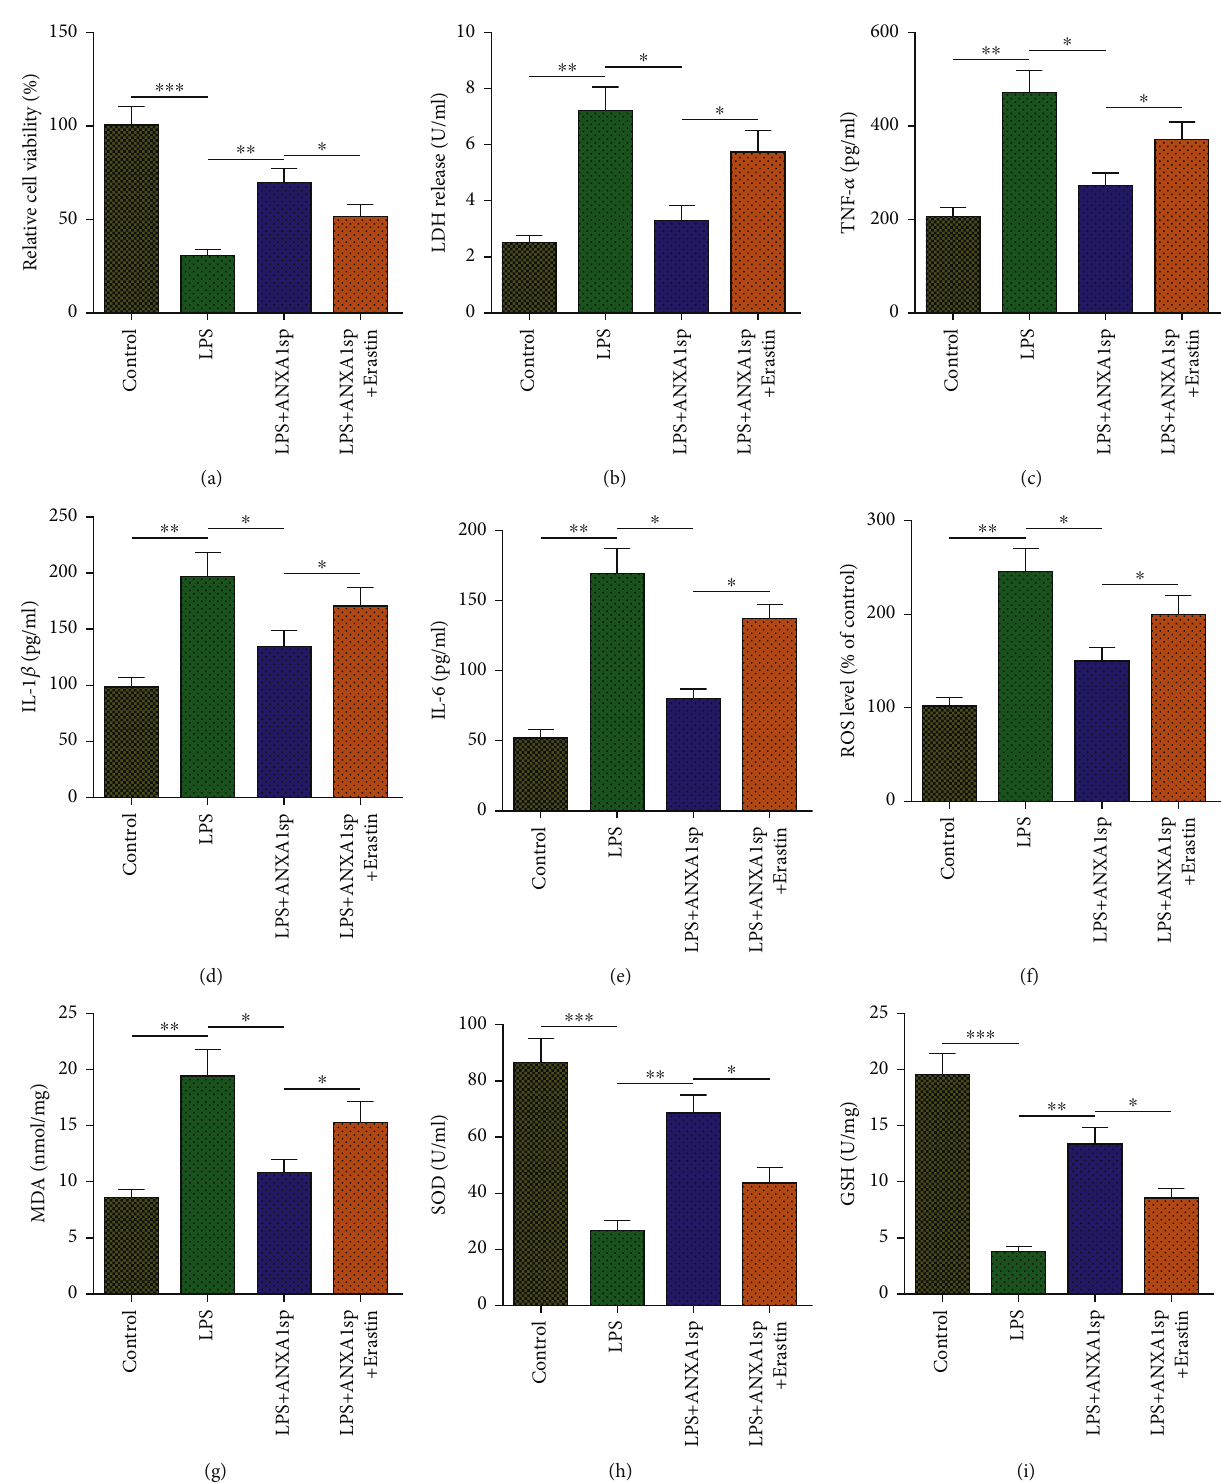
Figure 3: Erastin eliminates the protective e ff ect of ANXA1sp against LPS-induced H9C2 cell death, in fl ammation, and oxidative stress. H9C2 cells were assigned to control, LPS, LPS+ANXA1sp, and LPS+ANXA1sp+erastin groups. (a) CCK-8 for H9C2 cell viability in each group. (b) LDH level in H9C2 cell supernatant from each group. (c – e) ELISA for TNF- α , IL-1 β , and IL-6 levels in H9C2 cell supernatant. (f – i) ROS, MDA, SOD, and GSH levels in H9C2 cell supernatant. The experiments were repeated three times ( n = 3 ). Data were presented as mean ± SD . All statistical analyses were performed using Student ’ s t -test or one-way ANOVA. ∗ p < 0 : 05 ; ∗∗ p < 0 : 01 ; ∗∗∗ p < 0 : 001